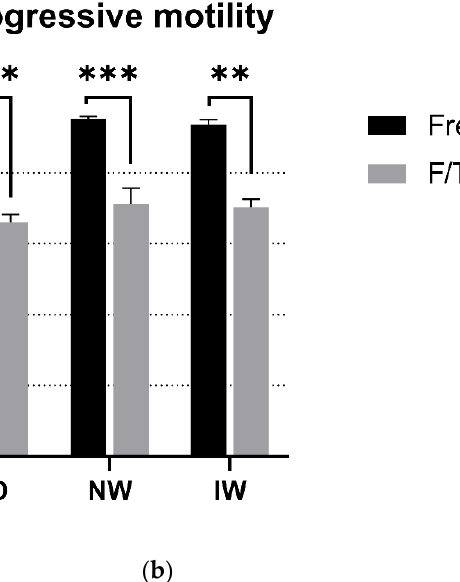
Figure 3. Comparative analysis of total ( a ) and progressive ( b ) motility among the breeds. SD — Slovak Dairy, NW — Native Wallachian, and IW — Improved Wallachian. No significant differences ( p > 0.05) between breeds were found. ** ( p < 0.01); *** ( p < 0.001) Significant difference between the fresh and F/T groups. The data are represented as means ± SEM.